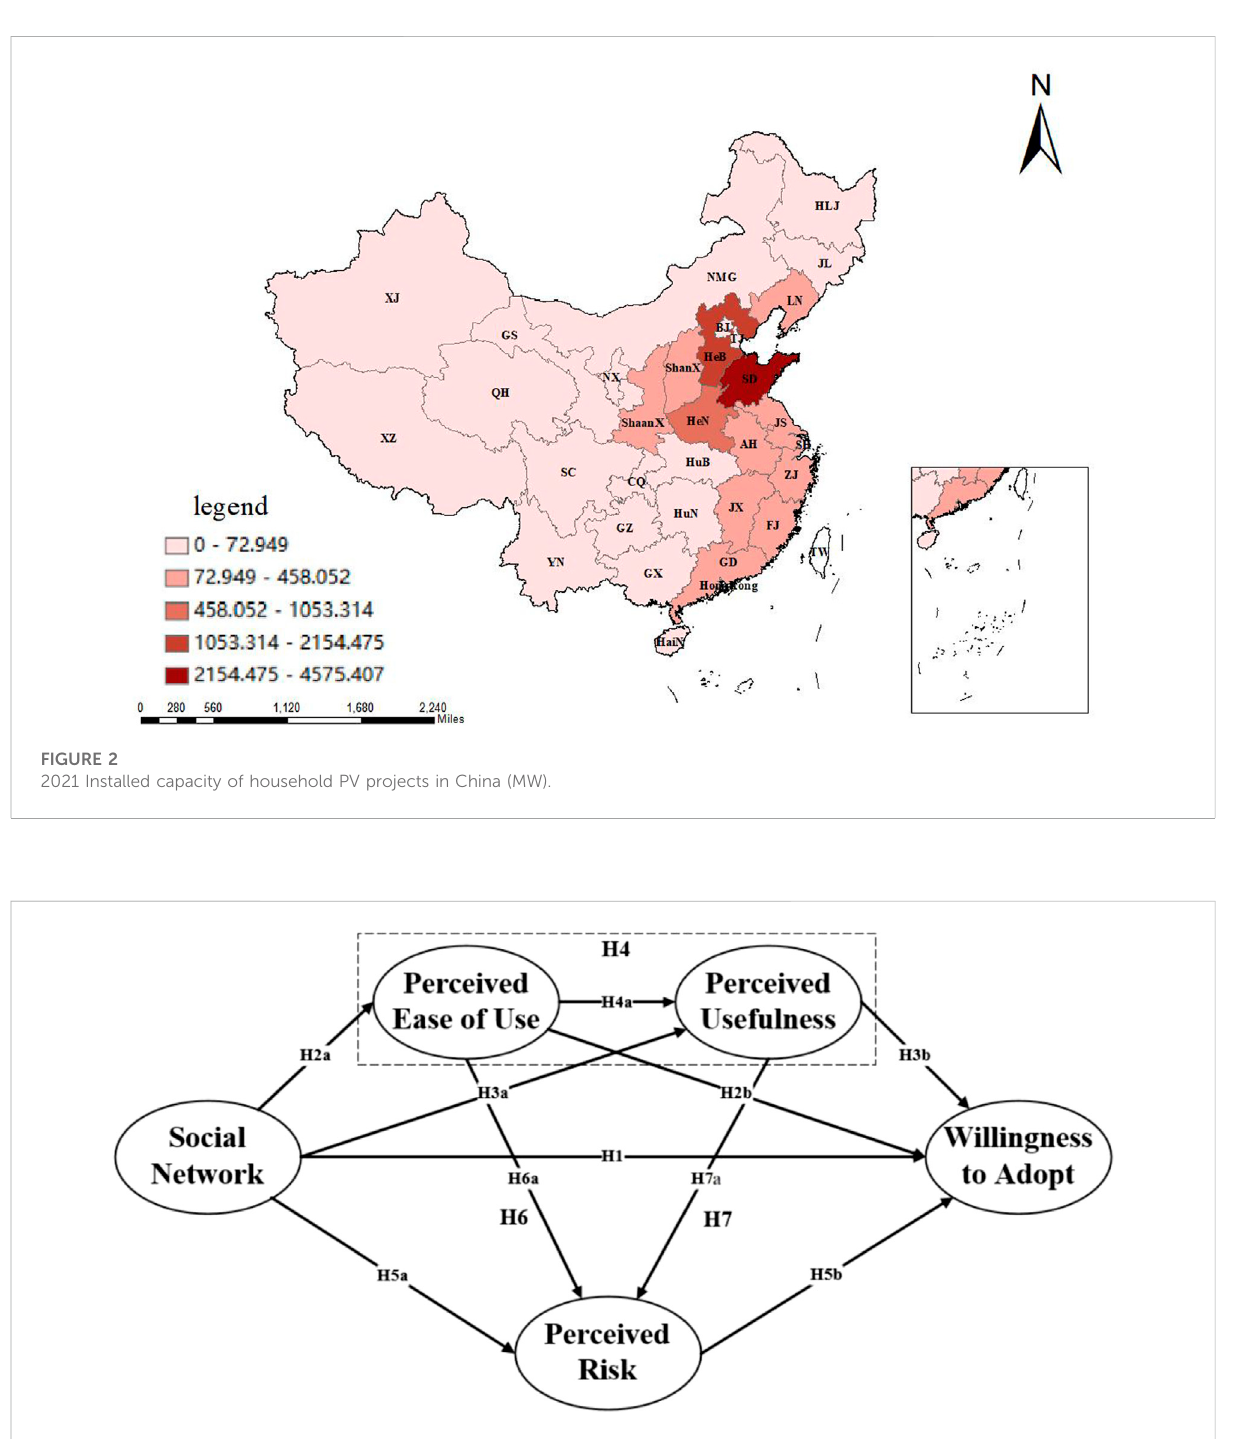
FIGURE 3 Research